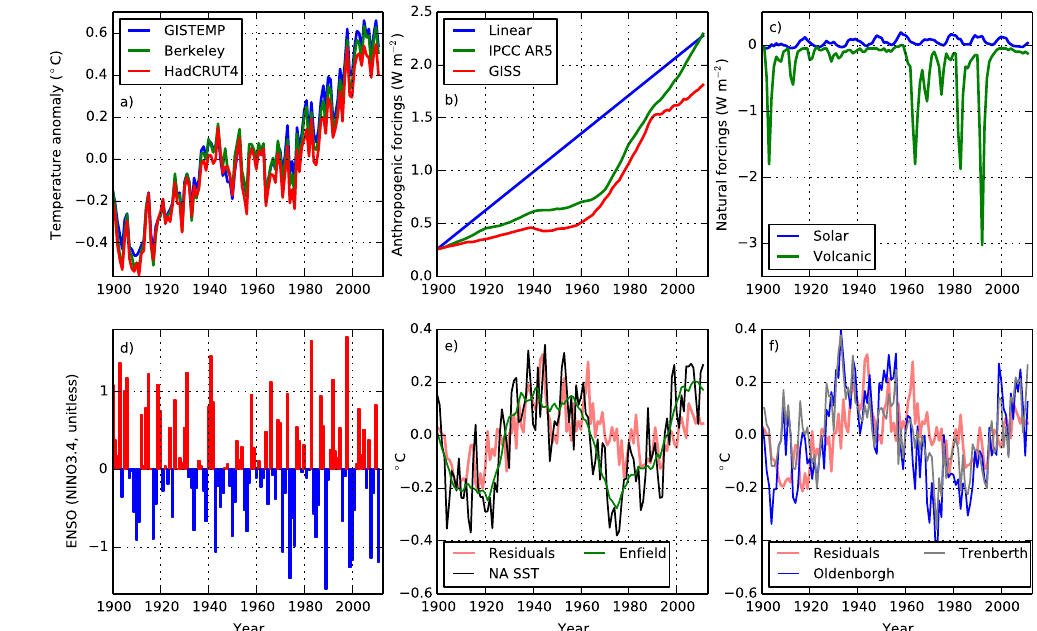
Figure 1. Input data sets used in this study: (a) three different temperature data sets, (b) anthropogenic forcings, (c) solar and volcanic forcings, (d) ENSO, (e) AMO characterizations based only on NA SST, and (f) AMO characterizations aiming to isolate the intrinsic AMO signal. Also shown in (e) and (f) are MLR residuals when explaining GISTEMP temperature with GISS anthropogenic radiative forcing as well as with solar and volcanic forcings, and ENSO as explanatory